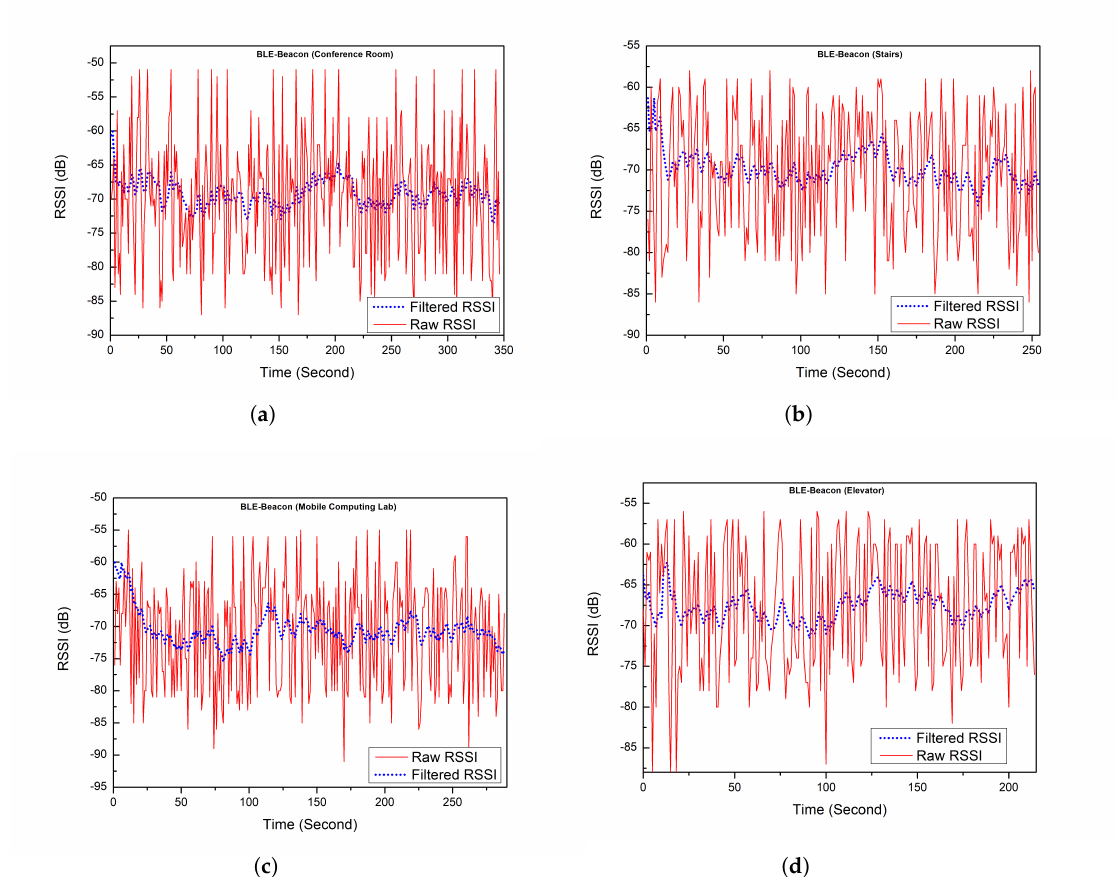
Figure 8. Filtered RSSI values and raw RSSI values. ( a ) BLE-beacon RSSI values around Conference room; ( b ) BLE-beacon RSSI values around stairs area; ( c ) BLE-beacon RSSI values around MCL; ( d ) BLE-beacon values around elevator